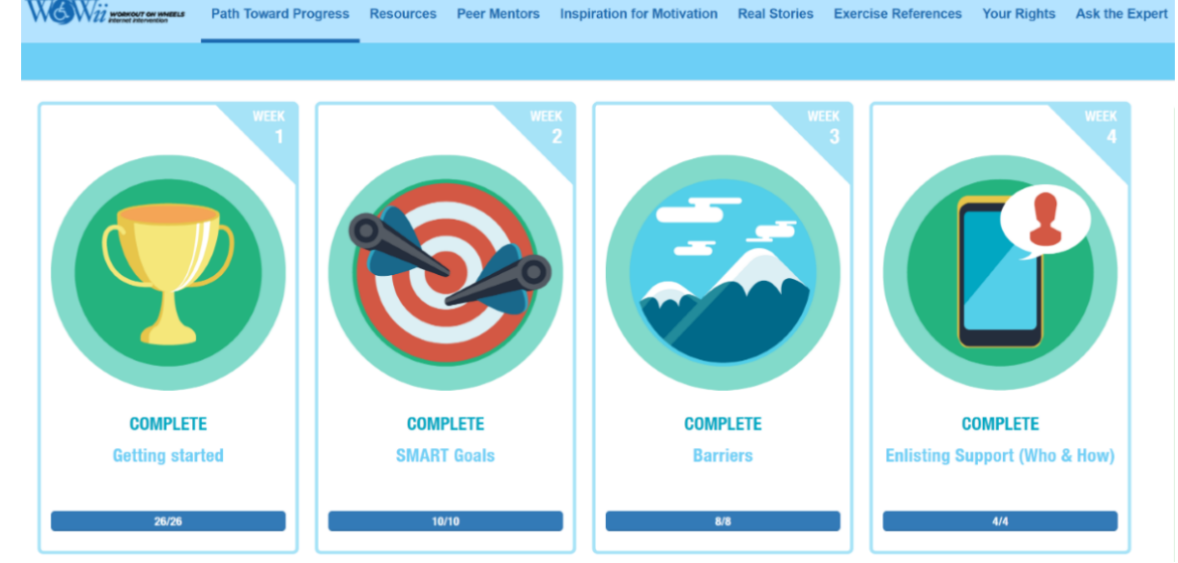
Figure 2. Workout on Wheels internet intervention (WOW ii ) website and module topics covered during the pilot